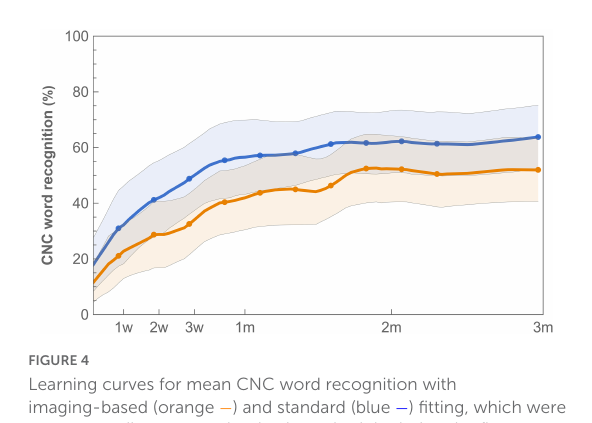
FIGURE4 Learning curves for mean CNC word recognition with imaging-based (orange − ) and standard (blue − ) fitting, which were worn according to a randomization schedule during the first 3 months of CI rehabilitation. Word recognition is defined as the average of test-retest values measured at 65 dB SPL. Error bands indicate 95% confidence